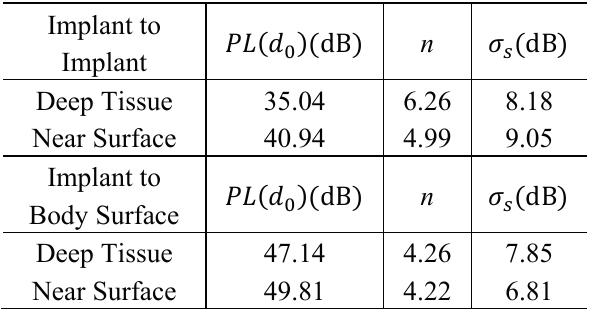
Table 1. Parameters used in path-loss